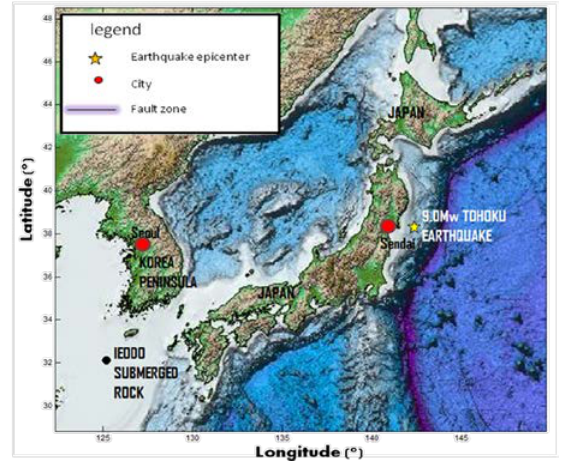
Figure 1. The location of 2011 9.0Mw earthquake epicenter (32.122N, 138.026E), ~1,310km from Seoul City, Korea Peninsula and ~1,530km from IEODO submerged